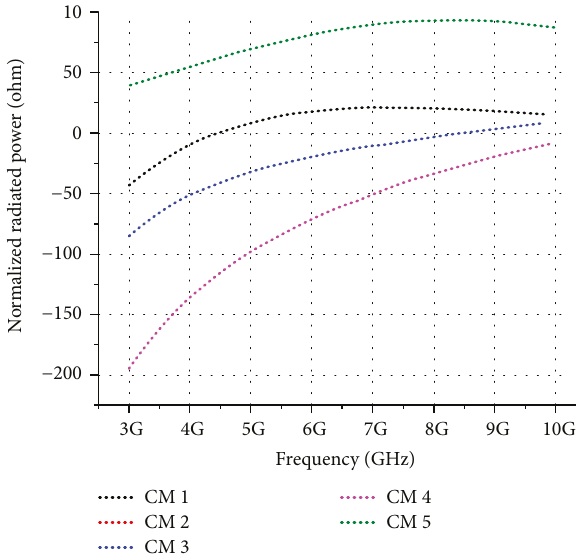
Figure 17: The normalized radiated powers corresponding to some typical CMs of the PEC plate shown in Figure 16.